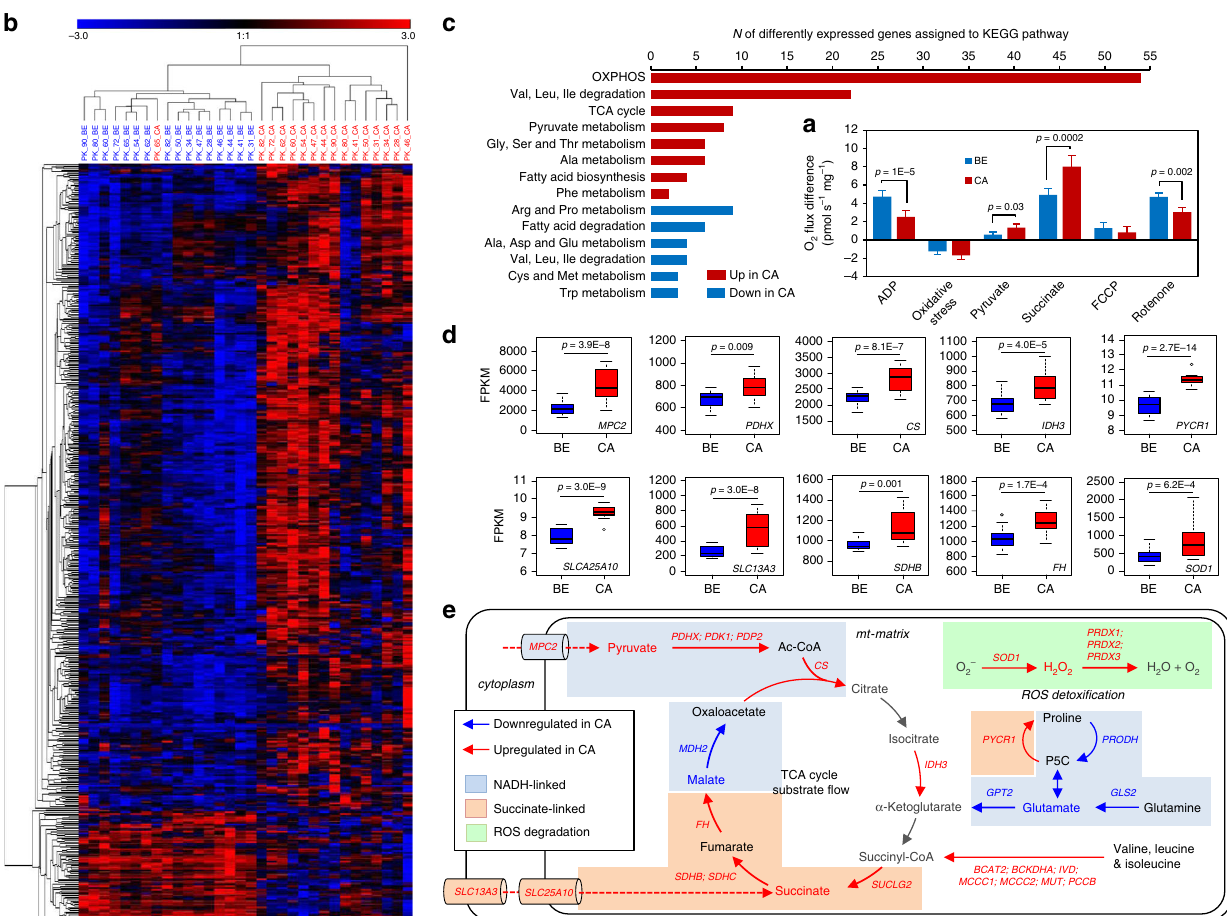
Fig. 7 Transcriptome pro fi le of mt-related genes. Differential mRNA expression of mitochondrial genes and enriched metabolic KEGG pathways were analyzed in 16 paired tissue samples representative for the sample cohort . a Respiratory characteristics of tissue samples for which RNA-seq expression analysis was performed. The effects of the substrates glutamate&malate, pyruvate, succinate, of oxidative stress, uncoupler FCCP, and CI inhibitor rontenone on O 2 fl ux in benign (blue, N = 16) and malignant (red, N = 16) tissue samples are shown. Data are presented as mean values ± SD. Differences were tested for signi fi cance using Wilcoxon signed-rank test. b Heatmap and hierarchical clustering of all signi fi cantly differentially expressed mt-related genes ( FDR < 0.01) based on the MitoCarta 2.0 Gene Catalog in the benign (blue) or malignant (red) tissue samples. c Enriched metabolic KEGG pathways upregulated (red) or downregulated (blue) in cancer tissue based on the InnateDB pathway overrepresentation analysis of all differentially expressed mt- related genes. d Boxplots representing Fragments Per Kilobase Million (FPKM) values for expression of signi fi cantly increased metabolic key-enzymes in the malignant (red, N = 16) vs the benign (blue, N = 16) tissue samples. Data are presented as boxplots with median, 25th – 75th percent percentile (box), minimum and median ± 1.5 IQR (whiskers) and minimum and maximum values (dots). Differences were tested for signi fi cance using multiple t -test followed by Benjamini – Hochberg correction for multiple testing. e Detailed annotation of single upregulated TCA-cycle key-enzymes in the benign (blue arrows) and malignant (red arrows) samples. Blue boxes mark steps mainly involved in NADH-linked electron transfer, orange boxes highlight steps related to succinate-linked electron transfer, and green boxes mark steps involved in ROS detoxi fi cation. Substrates used during the respirometry experiments are indicated in bold type while blue or red colored names and arrows mark enzymes and enzymatic reactions that are higher in either benign or malignant samples, respectively. Full names of enzymes are given in the main text. Source data are provided as a Source Data fi